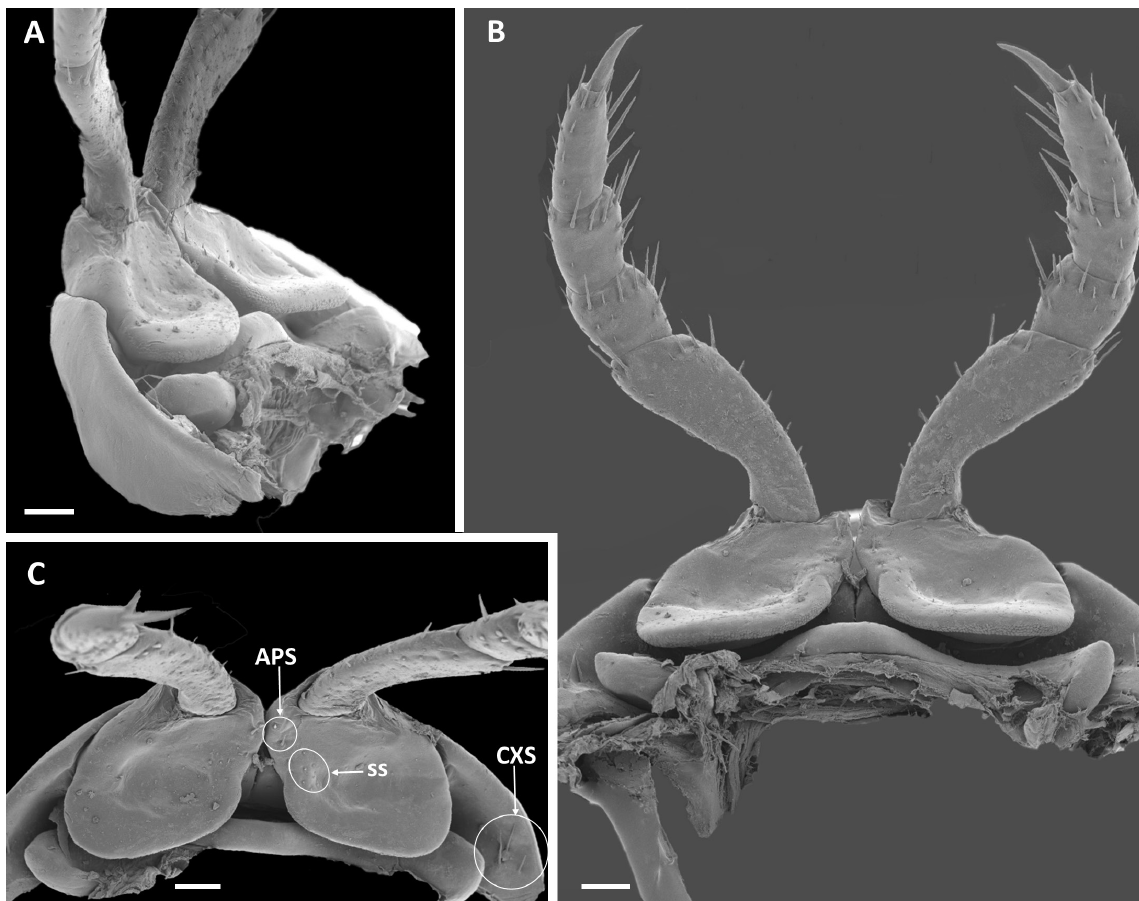
Fig. 13. Callistodontopyge latifolia (Attems, 1914), ♂, from Kiverenge FR (NHMD 621713), first pair of legs. A . Sublateral view. B . Anterior view. C . Ventral view. Abbreviations: APS = mesapical prefemoral setae; CXS = coxosternal setae; ss = smaller prefemoral setae. Scale bars = 0.2